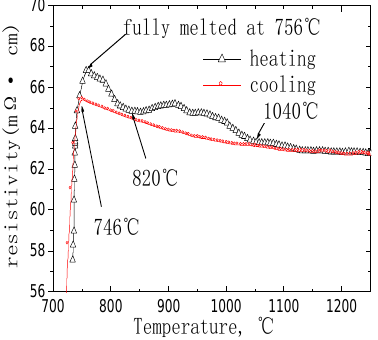
Figure 8. ρ- T curves of Cu-Sn30.